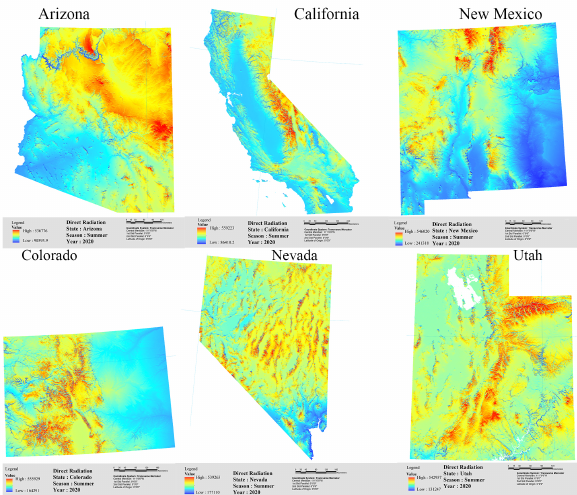
Figure 4. Solar Direct Radiation in